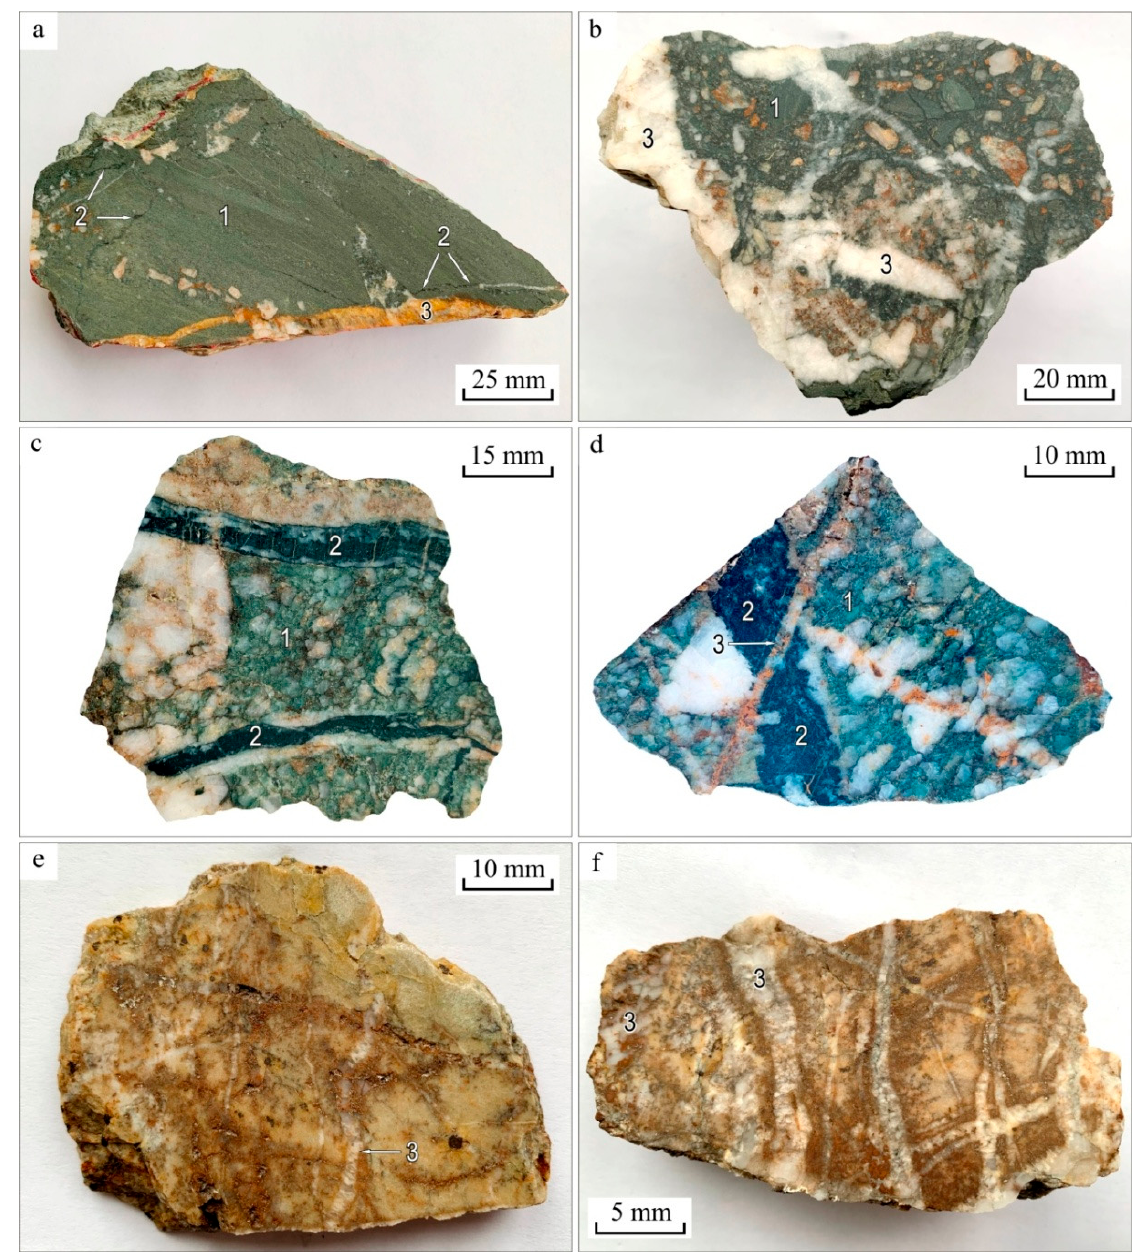
Figure 4. Altered rocks of the Ulug-Sair ore occurrence: ( a ) quartz–tourmaline rocks (1) with tourmaline–quartz (2) and gold–sulfide–quartz (3) veins of the latest substages; ( b ) brecciated fragments of quartz–tourmaline rocks (1) in gold–sulfide–quartz mineral aggregates (3); ( c , d ) ore-bearing conglomerates (1) with tourmaline–quartz (2) and sulfide–quartz (3) veins; ( e , f ) beresite with gold–sulfide–quartz veins after ( e ) granite-porphyry (3); ( f ) quartz sandstone (3). The chemical composition of tourmaline from quartz–tourmaline-altered rocks and veins shows that they are related to the intermediate members of the dravite–magnesio- foitite series [34].